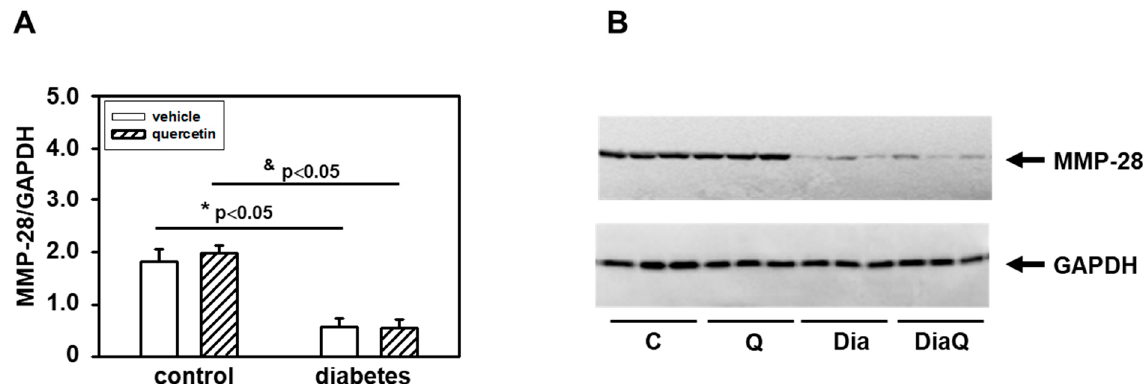
Figure 4. Effects of quercetin treatment on protein levels of matrix metalloproteinase-28 (MMP-28) in left ventricular tissue of control lean and obese diabetic Zucker Diabetic Fatty (ZDF) rats. ( A ) Quantification of MMP-28 content normalized to glyceraldehyde-3-phosphate dehydrogenase (GAPDH) protein levels. Each bar represents mean ± SEM, n = 6–7. Statistical significance was revealed by Student’s unpaired t -test, * p < 0.05 vs. control lean vehicle-treated rats, & p < 0.05 vs. control lean quercetin-treated rats. ( B ) Western blots records showing the changes in protein levels of MMP-28 and GAPDH. C—control lean vehicle-treated ZDF rats; Q—lean quercetin-treated ZDF rats; Dia—obese diabetic vehicle-treated ZDF rats; DiaQ—obese diabetic quercetin-treated ZDF rats.